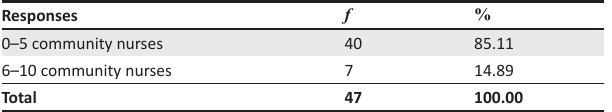
TABLE 8: Respondents’ indication of the number of community nurses working with tuberculosis patients in their clinics ( n = 47).